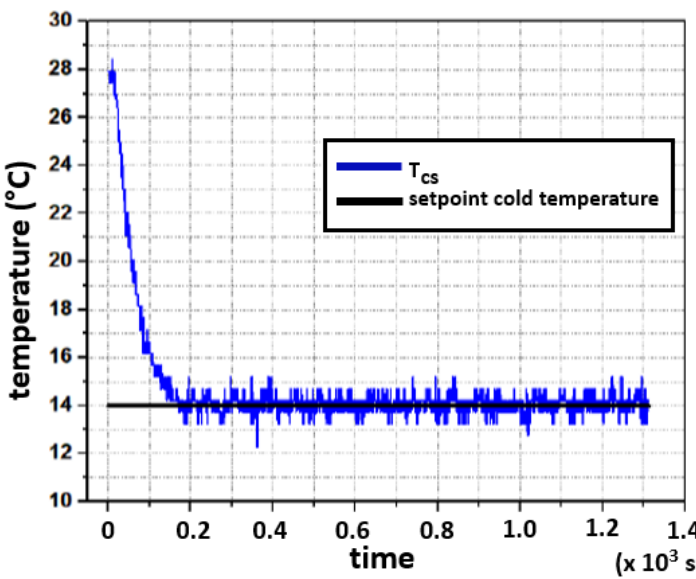
Figure 13. Experimental closed-loop response for the cold side. The setpoint is 14 ◦ C.